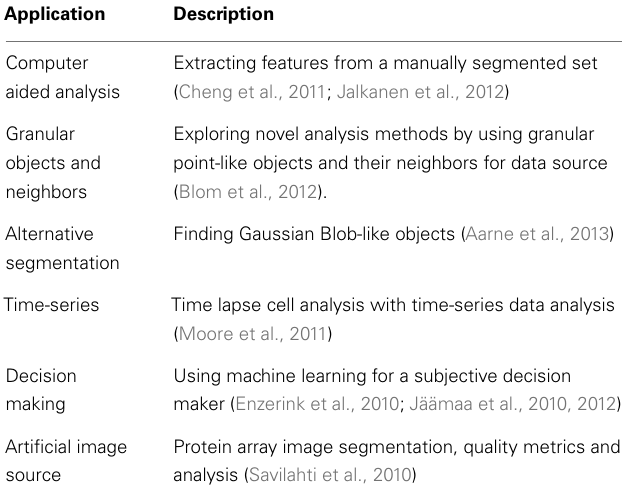
FIGURE 5 | Comparison of segmentation accuracies in the BBBC005v1 benchmark set .The ground truth contains 30,300 cells for each focus level. The graph is generated in the pipeline analyzing the data.